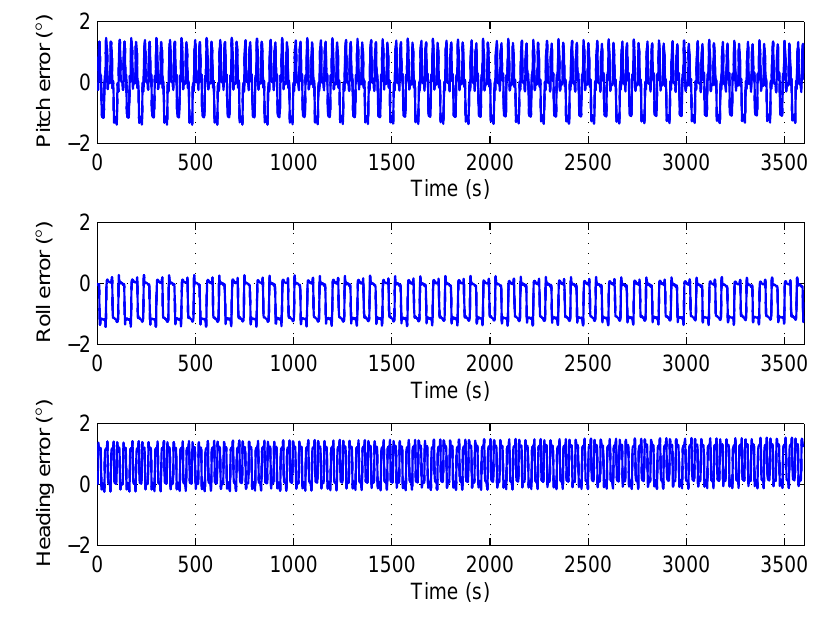
Figure 7. Average attitude and heading errors with long term drift added to bias. The dash lines are 1 σ envelopes.